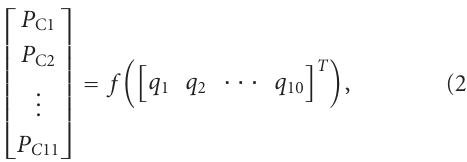
Figure 6: Model with distributed mass: (a) absolute angles, (b) generalized coordinates (angles are relative joint coordinates).